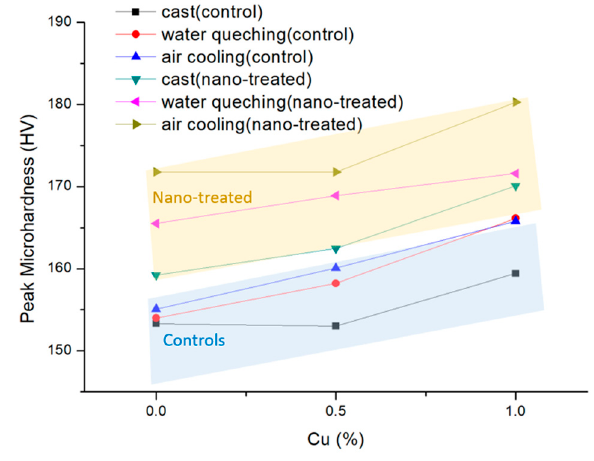
Figure 5. Peak microhardness of all samples during natural aging in 44 days.